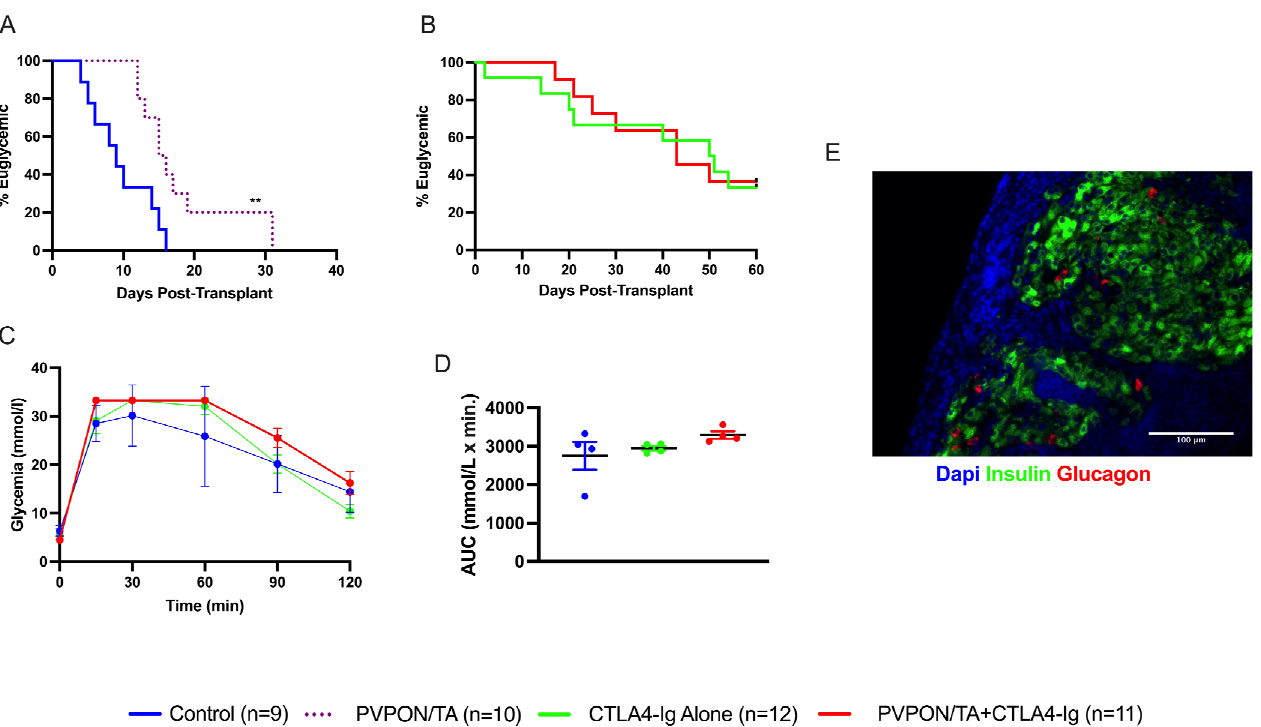
Figure 5. Transplantation of PVPON/TA-coated murine islets delays allograft rejection. Kaplan–Meier Log-rank survival curve of STZ-treated C57BL/6 recipients transplanted with 500 BALB/c control islets (blue, n = 9) or PVPON/TA-coated islets (purple dash, n = 10) under the kidney capsules ( A ). Kaplan–Meier Log-rank survival curve of STZ-treated C57BL/6 recipients transplanted with 500 BALB/c islets + CTLA4-Ig (green, n = 12) or PVPON/TA-coated islets + CTLA4-Ig (red, n = 11) under the kidney capsule ( B ). Intraperitoneal glucose tolerance test (IPGTT) on allogeneic euglycemic recipients 60 days post-transplant for naïve non-diabetic mice (blue, n = 4), islets + CTLA4-Ig (green, n = 4), PVPON/TA-coated islets + CTLA4-Ig (red, n = 4) ( C ). Two-way ANOVA with multiple comparisons for the area under the curve (AUC) of the 60-day IPGTT ( D ). Immunohistochemistry of mouse allograft transplanted with PVPON/TA-coated islets + CTLA4-Ig, explanted 60 days post-transplant ( E ). ** p < 0.01.